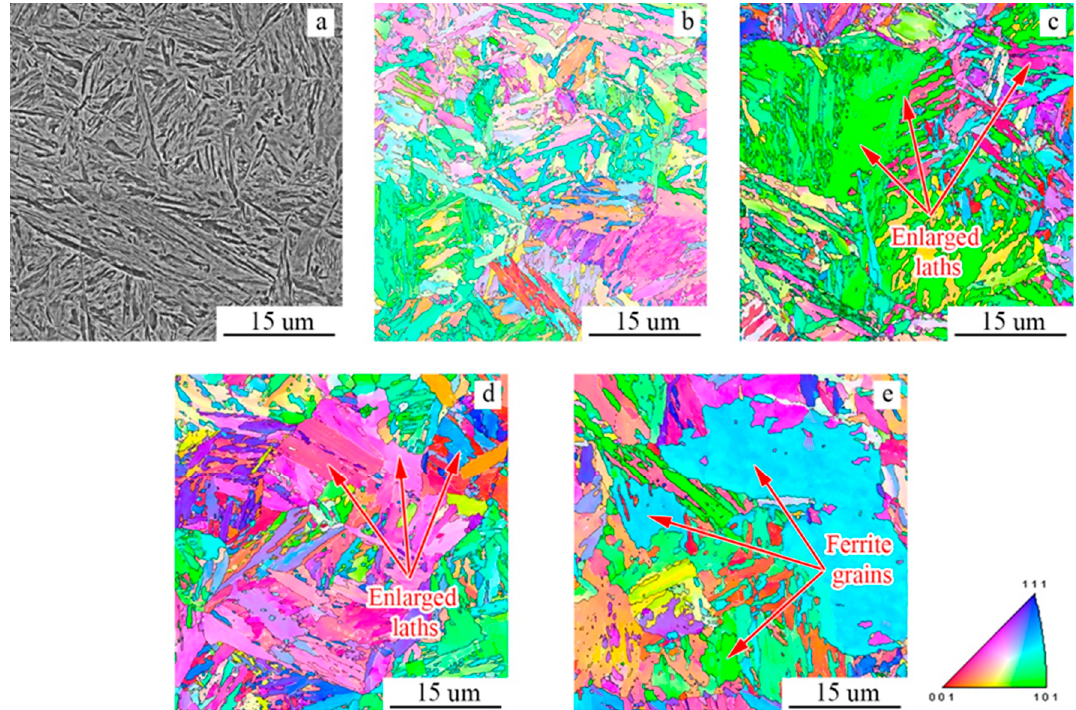
Figure 5. The initial microstructure ( a ) and inverse pole figures (IPF) maps ( b–e ) of Fe-0.36wt.%C- 1wt.%Cr steel in as-quenched condition ( a ) and after soaking at 400 ( b ), 500 ( c ), 600 ( d ) or 700 °C ( e ) for 10 min.